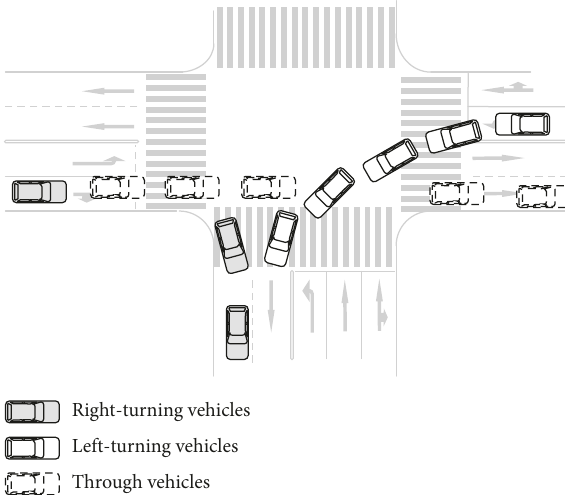
m N . In this case, the number of Case 3 0 1 / 2 T R ) ( ( ) + right-turning vehicles is less than that of the crossing- < <